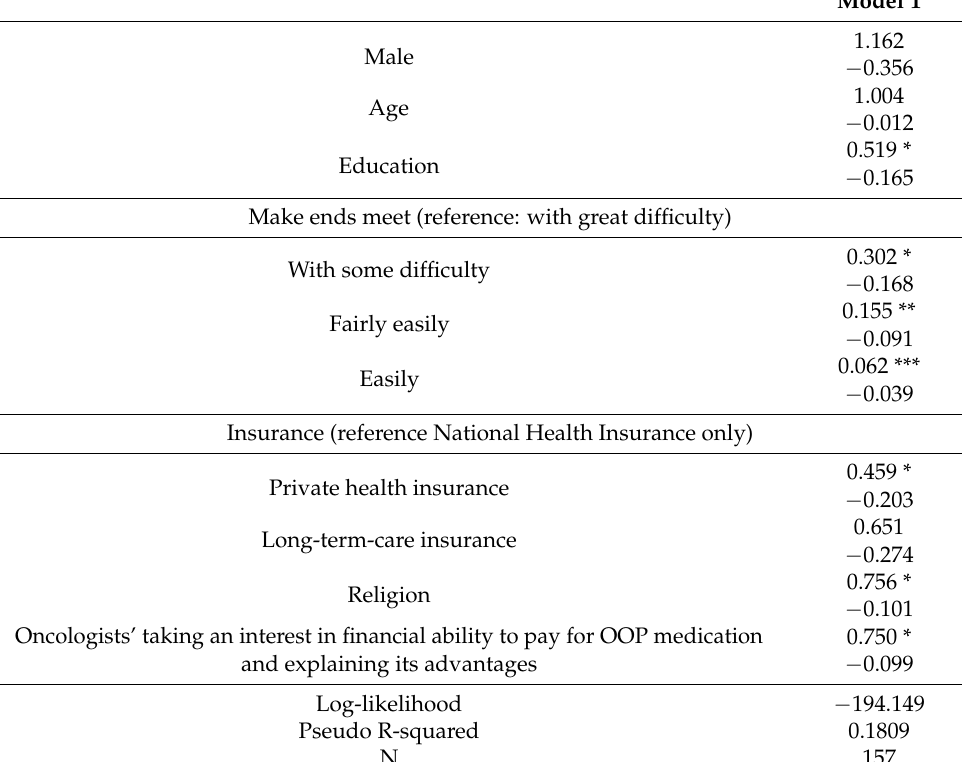
Table 3. Ordered logit regression analysis to explain financial burden caused by out-of-pocket spending on medication (Explained variable: financial burden caused by out-of-pocket spending on medication: 1—none, 4—very large (odds